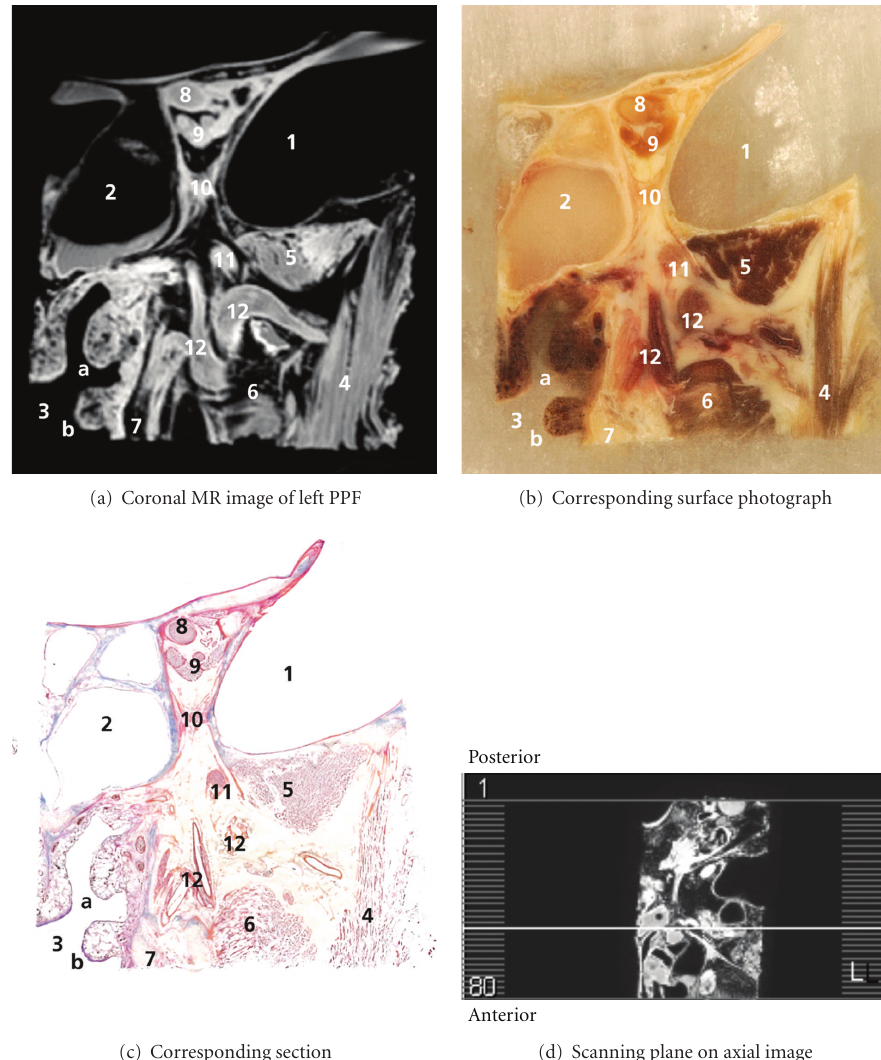
Figure 1: 1: middle cranial fossa, 2: sphenoidal sinus, 3: nasal cavity with (a) middle concha and (b) inferior concha, 4: temporal muscle, 5: lateral pterygoid muscle, superior head, 6: lateral pterygoid muscle, inferior head, 7: medial pterygoid muscle, 8: optic nerve, 9: common annular tendon (of Zinn) with origins of the medial, inferior, and lateral rectus muscles, 10: orbital or Muller’s muscle, 11: maxillary nerve, and 12: sphenopalatine